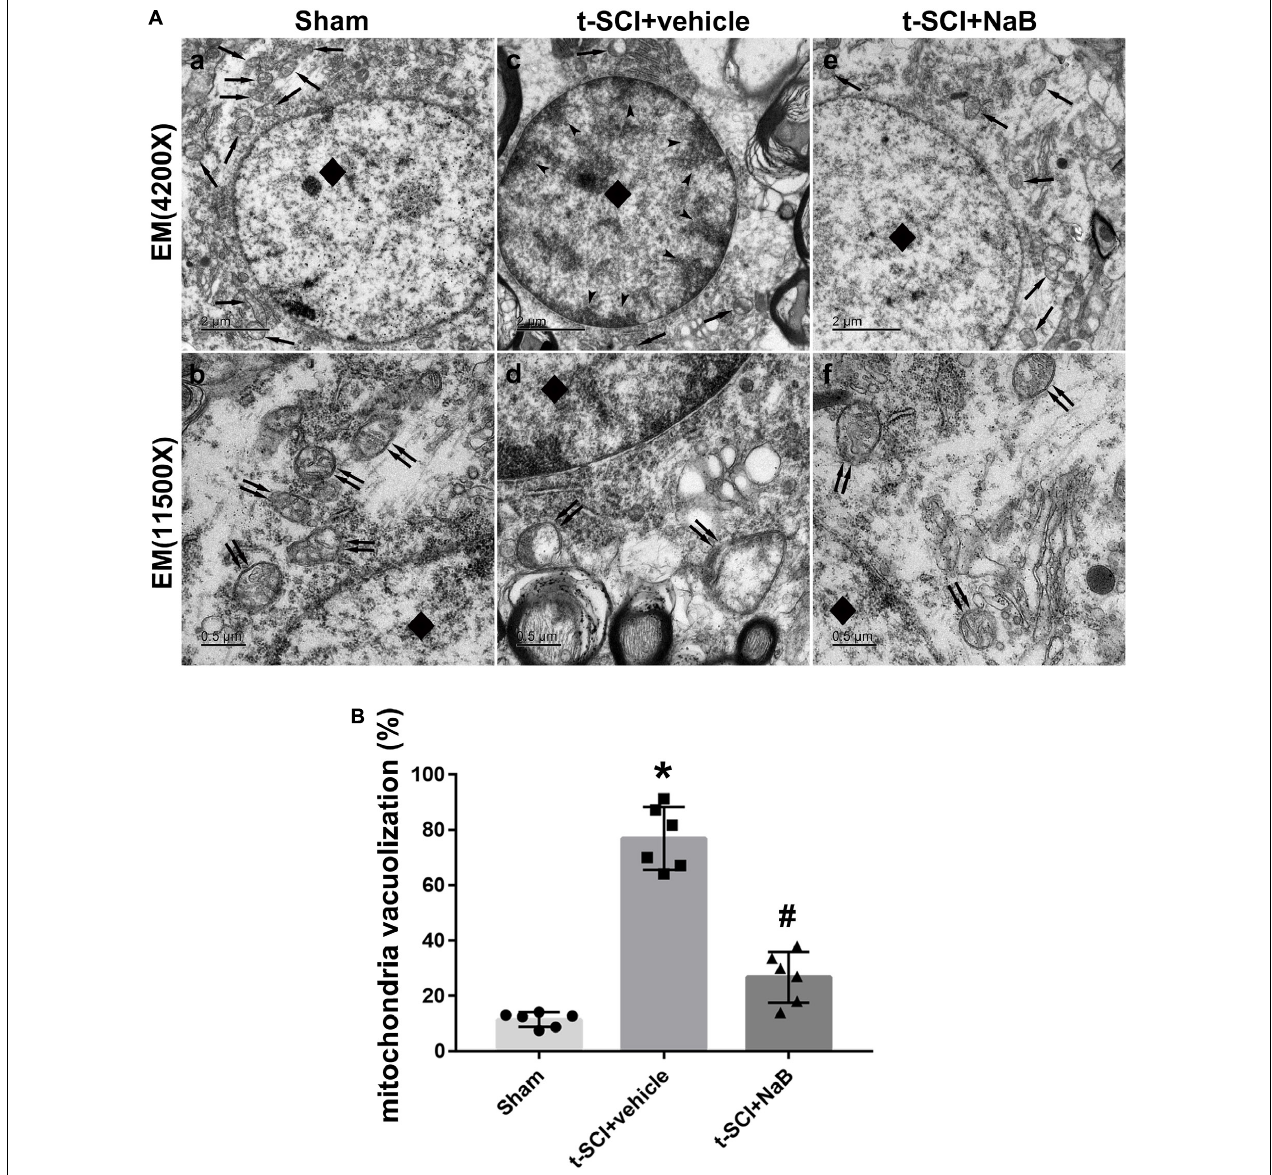
FIGURE 8 | Representative TEM micrographs showing ultrastructural changes of spinal cord neurons in each group at 24 h post-injury. Normal nucleus (diamond) and mitochondrion (arrows) in the sham group (A, a) ; normal mitochondrion (double arrows) with clear crista in the sham group (A, b) ; karyopyknosis (diamond), chromatin condensation, and margination (dovetail arrows), disappearance of the nucleolus, mitochondrial loss (arrows) in the SCI + vehicle group (A, c) ; mitochondrial swelling, vesiculation, and disappearance of the crista (double arrows) in the SCI + vehicle group (A, d) ; treatment with NaB reversed neuronal apoptosis, and the subcellular structure reverted to near normal (A, e,f) . N = 6 for each group. (B) The proportion of mitochondrial vacuolization significantly increased after t-SCI, NaB treatment significantly decreased the proportion of mitochondrial vacuolization. Data is expressed as mean ± SD and analyzed by one-way ANOVA and Bonferroni’s post hoc multiple comparisons test. ∗ p < 0.05 versus sham; # p < 0.05 versus t-SCI +